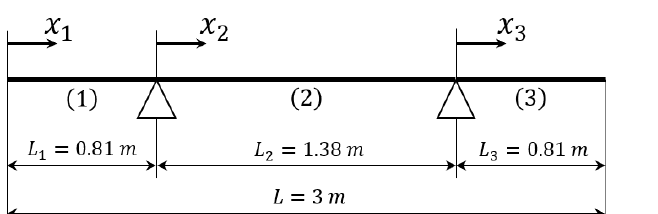
Figure 3. Geometrical scheme of the deployed slat. The slat is divided in three parts with length L i and local reference frame x i , i =